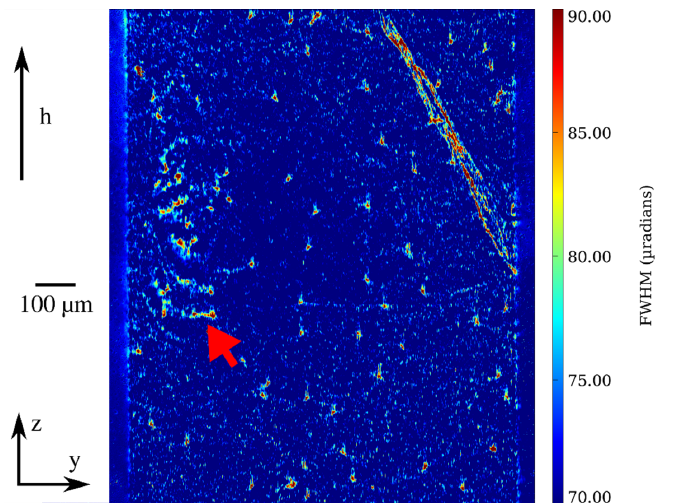
Figure 2. RCI peak width (FWHM) map of the 4H-SiC crystal. The red dots are the images of dislocations perpendicular to the surface. The red arrow indicates a pair of dislocations connected by an area exhibiting a higher FWHM than the matrix. The projection of the diffraction vector h, the scale, and the vertical z and horizontal y directions are indicated on the left side.